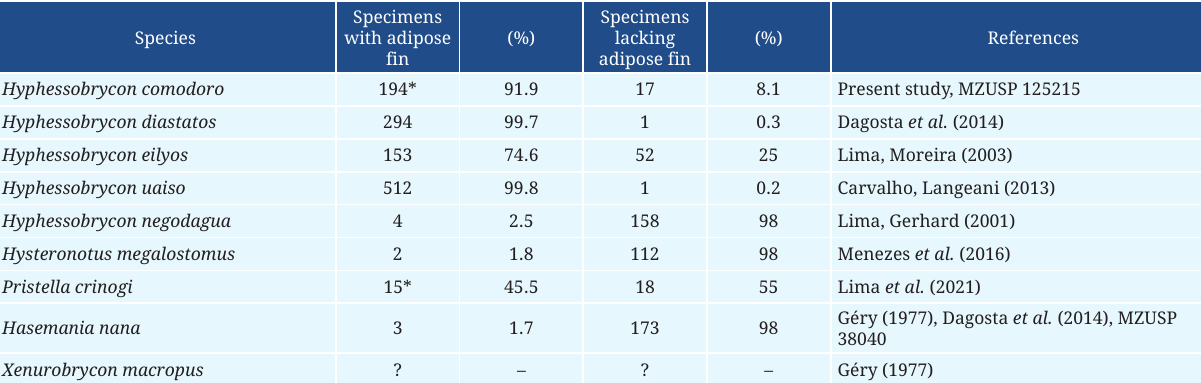
TABLE 2 | List of species of Characidae showing intraspecific variation in the absence/presence of the adipose fin. Counts with an asterisk include specimens with vestigial adipose